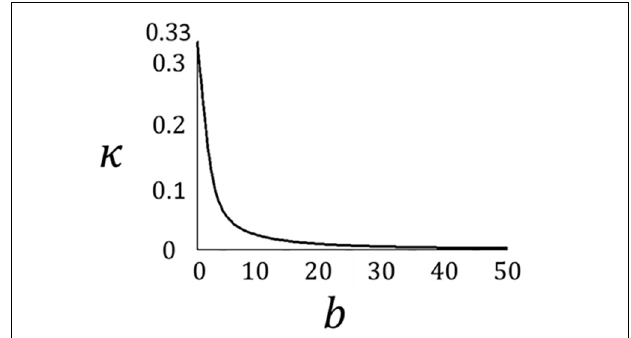
FIGURE 4 | Dispersion- concentration parameter curve obtained from Equation 19.